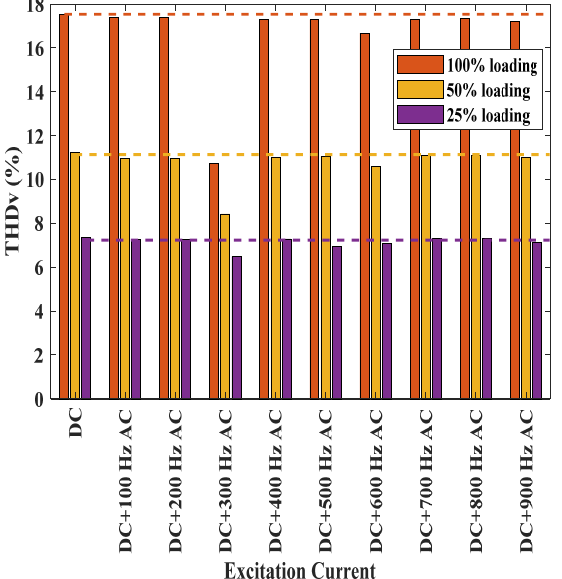
Figure 5. Lowest THD V values obtained for the tested excitation currents.